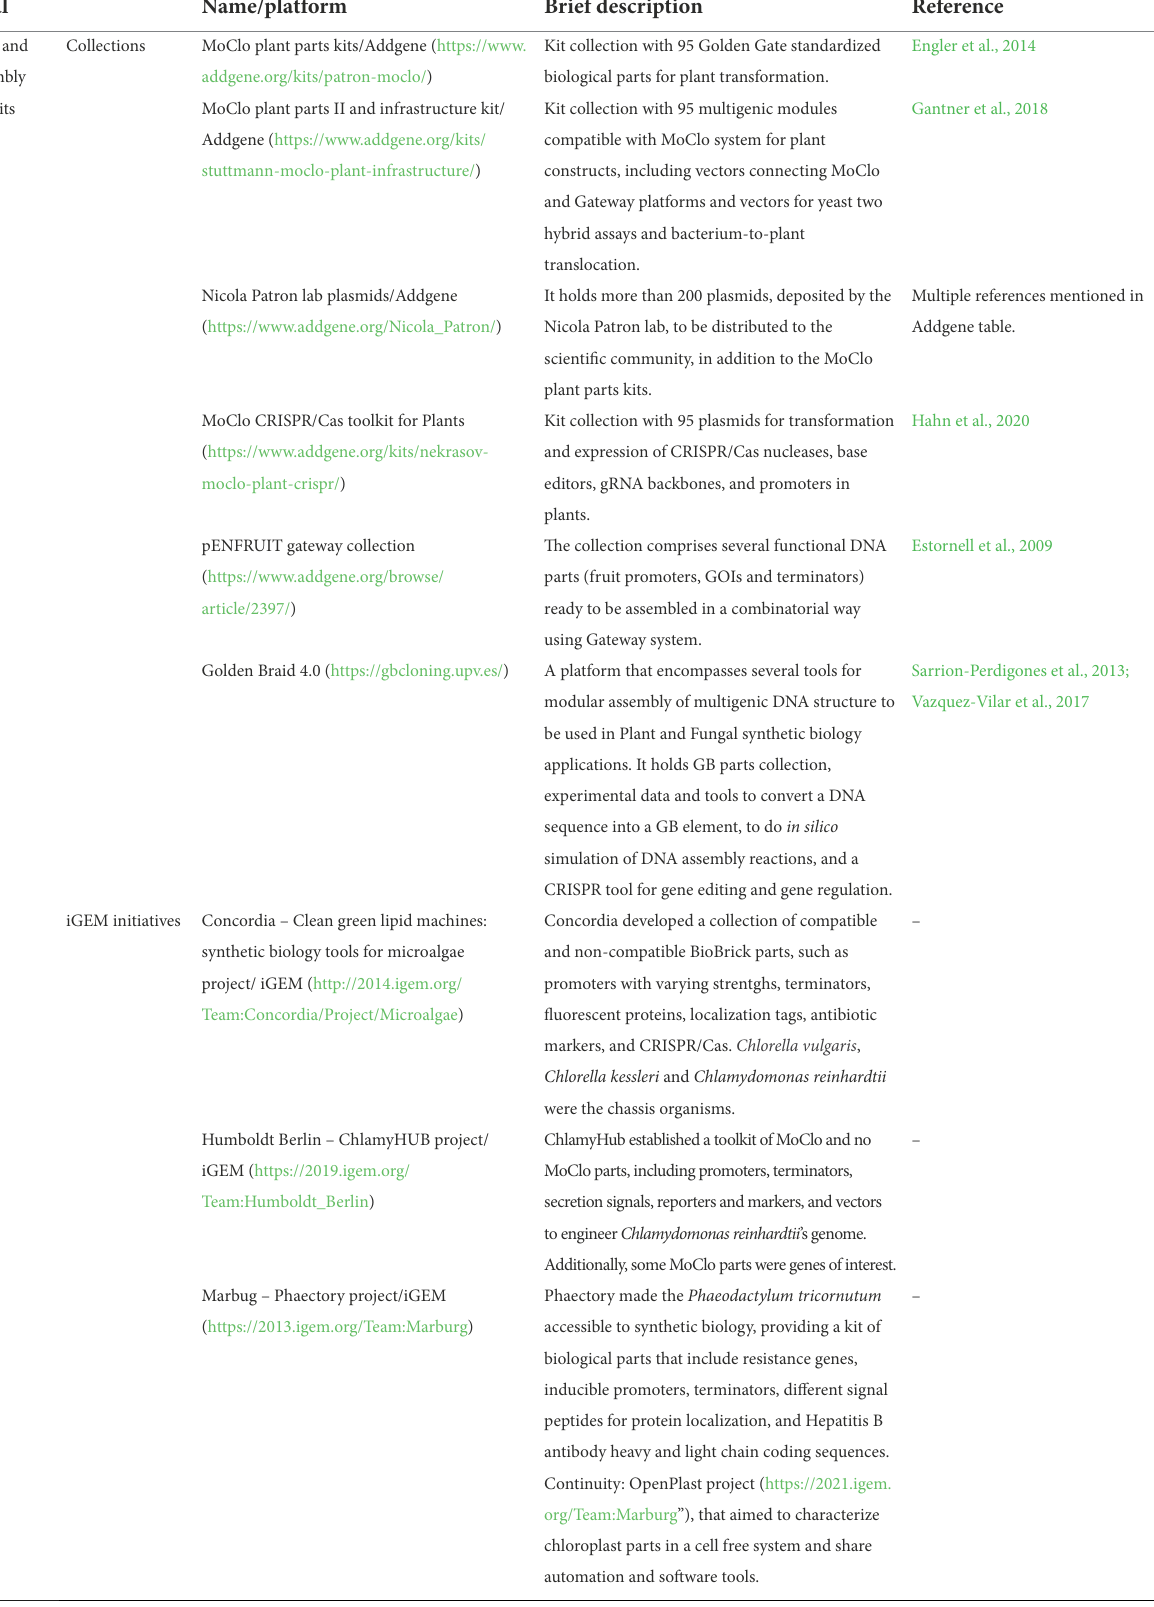
TABLE 1 Synthetic biology tools for plants and